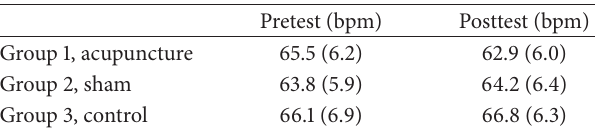
Table 2: Physiological responses (heart rate) for athletes in pre- and postintervention.